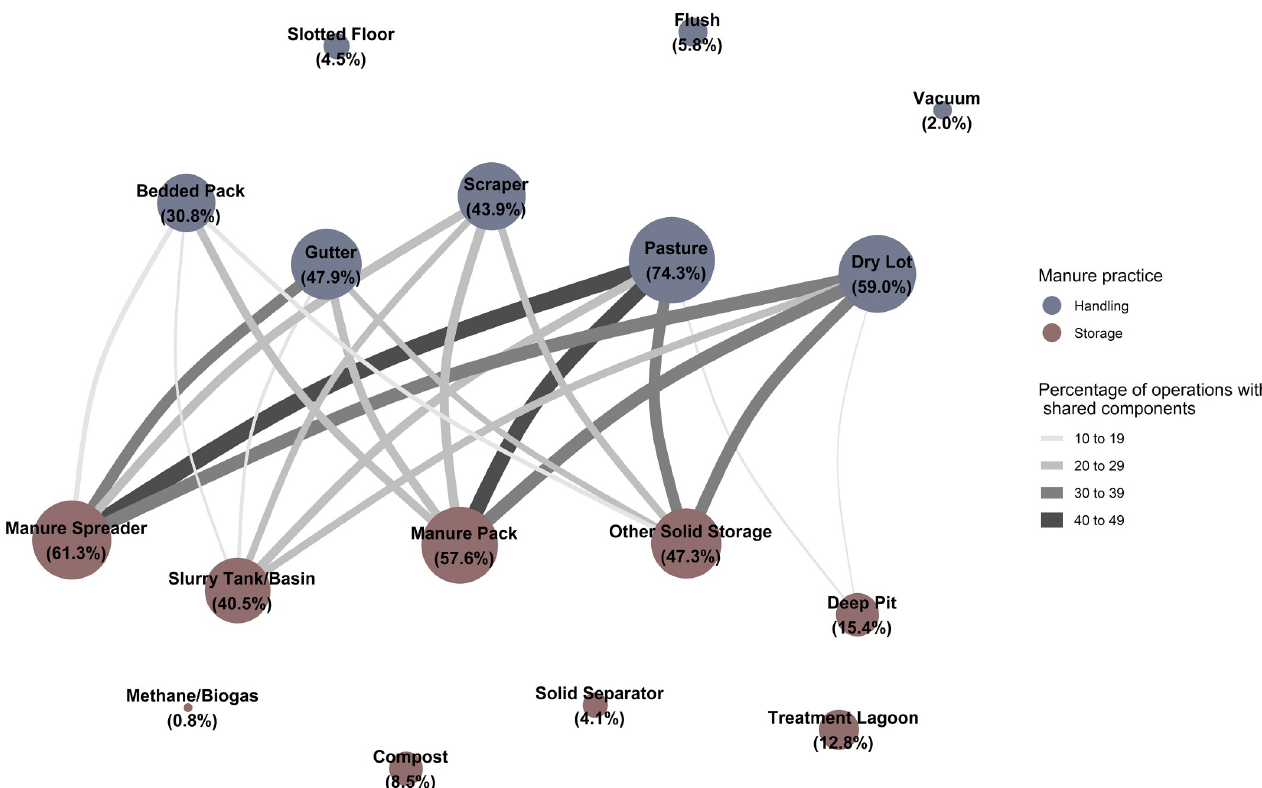
Fig 4. Network graph showing the percentage of operations practicing the given manure handling (blue) and storage (red) strategies (diameter of nodes) and the percentage of operations practicing handling-storage pairs of strategies together (width of edges, with widths colored by group based on magnitude of percentage). Edges representing percentages of 10 or less were suppressed Edge percentages for this figure are located in the Supporting Information S2